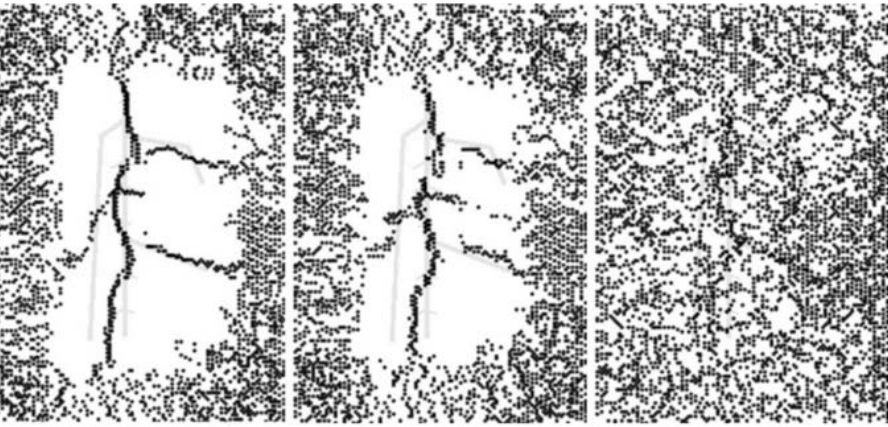
Figure 9. Prediction results of FEA model with roots buried at 2 mm ( left ), 5 mm ( middle ), and 6 mm ( right ).